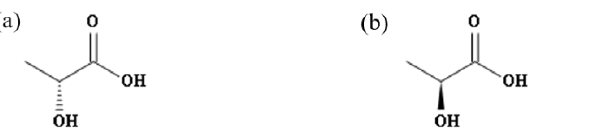
Figure 1. ( a ) D-lactic acid (CAS: 10326-41-7); ( b ) L-lactic acid (CAS: 79-33-4).